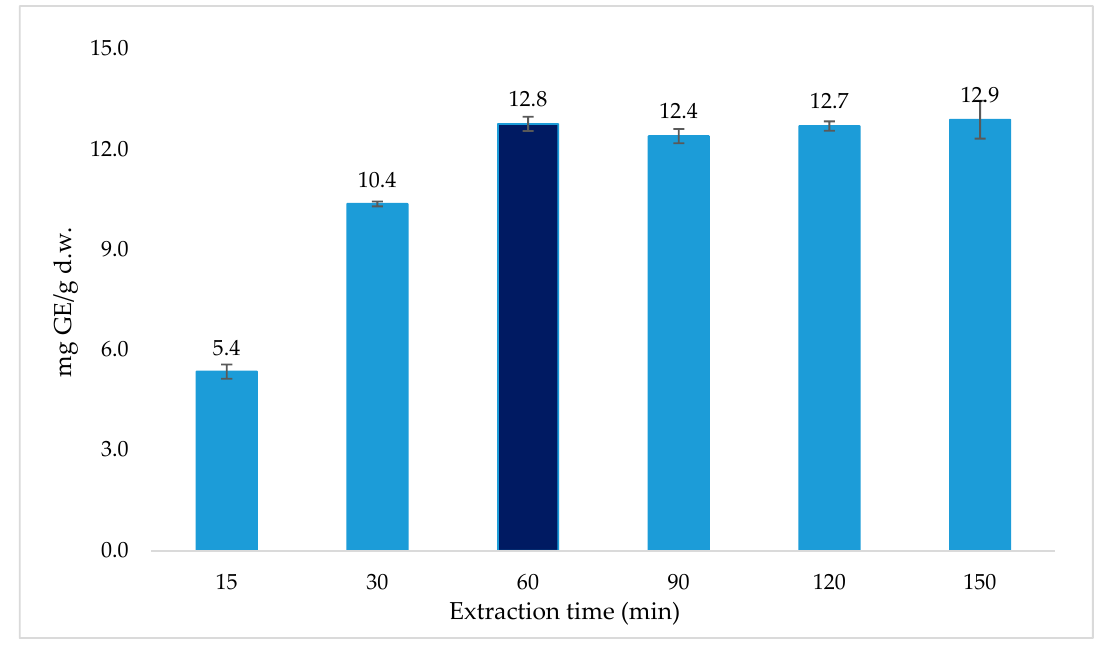
Figure 5. Effect of extraction time. Figure 5. E ff ect of extraction